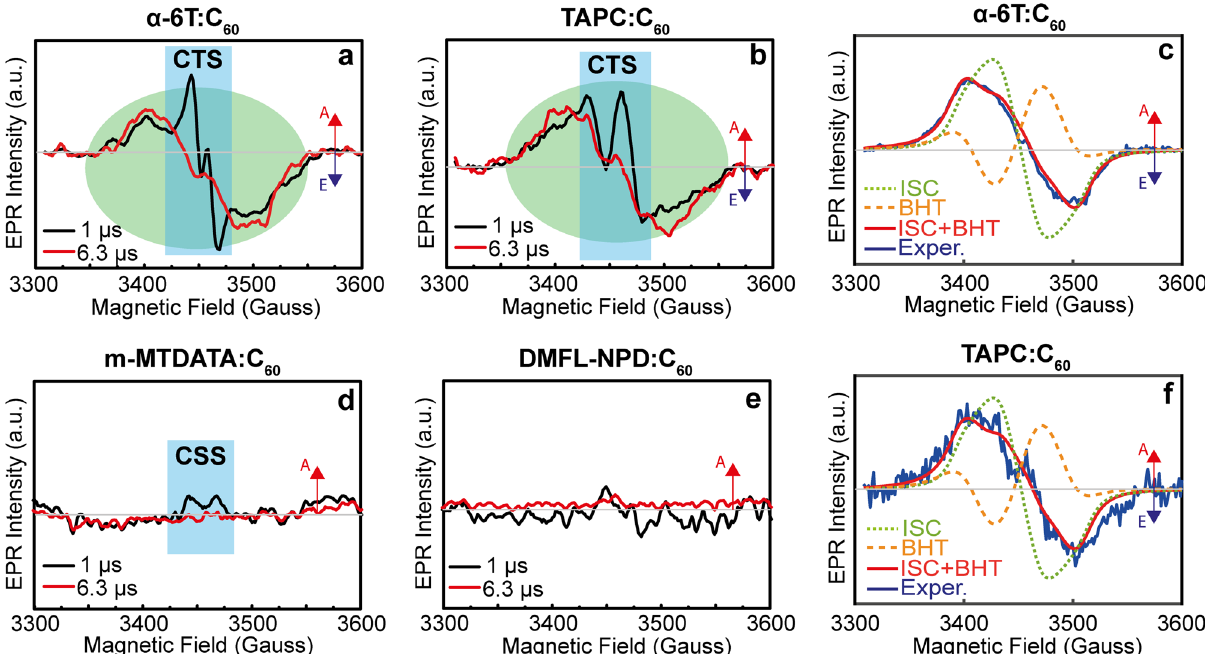
Fig. 4 TREPR spectra and triplet formation pathways in the dilute (6% molar) blends. a , b , d , e Smoothed TREPR spectra of dilute α -6T:C 60 , TAPC:C 60 , m-MTDATA:C 60 , and DMFL-NPD:C 60 recorded at 1 (black line) and 6.3 µ s (red line) after a 532 nm laser pulse. All the measurements are performed at 80 K. c , f Best- fi t spectral simulations (red line) of TREPR spectra (blue line) of α -6T:C 60 and TAPC:C 60 dilute blends taken at 6.3 µ s after a 532 nm laser pulse. Two different contributions have been considered in the simulation: intersystem crossing (dotted green line) and back-hole transfer (dashed orange line). The signal regions corresponding to CT states (CTS) and charge separated states (CSS) are highlighted in blue and those corresponding to C 60 triplets in green in b , c , and f